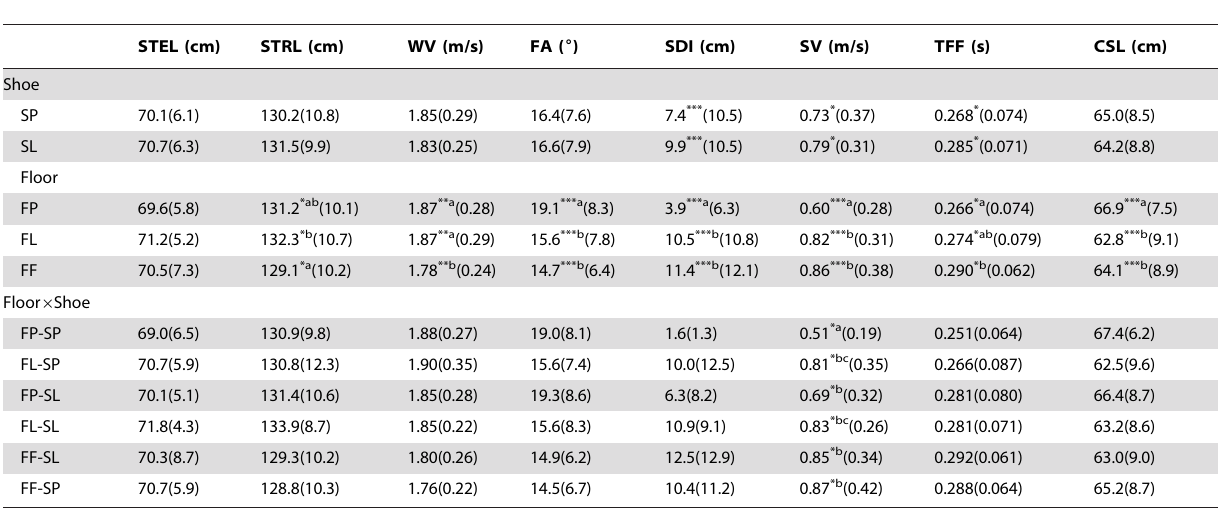
Table 2. Tempo-spatial variables under shoe, floor and shoe 6 floor conditions.